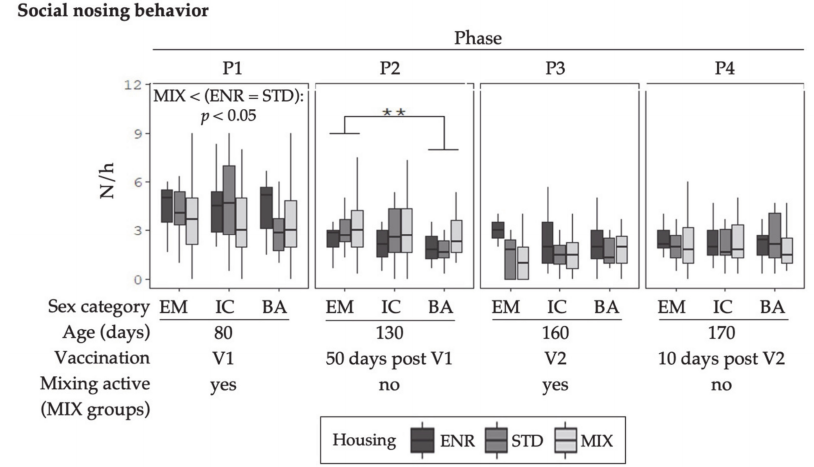
Figure 5. Mean number of occurrences (N) of social nosing per hour (h) for each animal are given as boxplots for the sex categories in the different environments. Columns represent the data of animals in four different behavior observation phases (P1–P4). V1 represents phases before, and V2 after the second immunization of IC. The MIX pens were mixed in P1 and P3. Note: no mixing was done in STD and ENR at any time. Sex categories were: EM = entire males, IC = immunocastrates, BA = barrows; Housing environments were: ENR = enriched, STD = standard, MIX = mixing. Significant differences between sex categories are indicated by asterisks (*** p < 0.001, ** p < 0.01, * p < 0.05), whereas for tendencies p -values are given. Housing differences are annotated with p -values in the graphs respectively. Boxplots show the minimum value with respect to the interquartile range, the 25th percentile, the median, the 75th percentile and the maximum value with respect to the interquartile range.